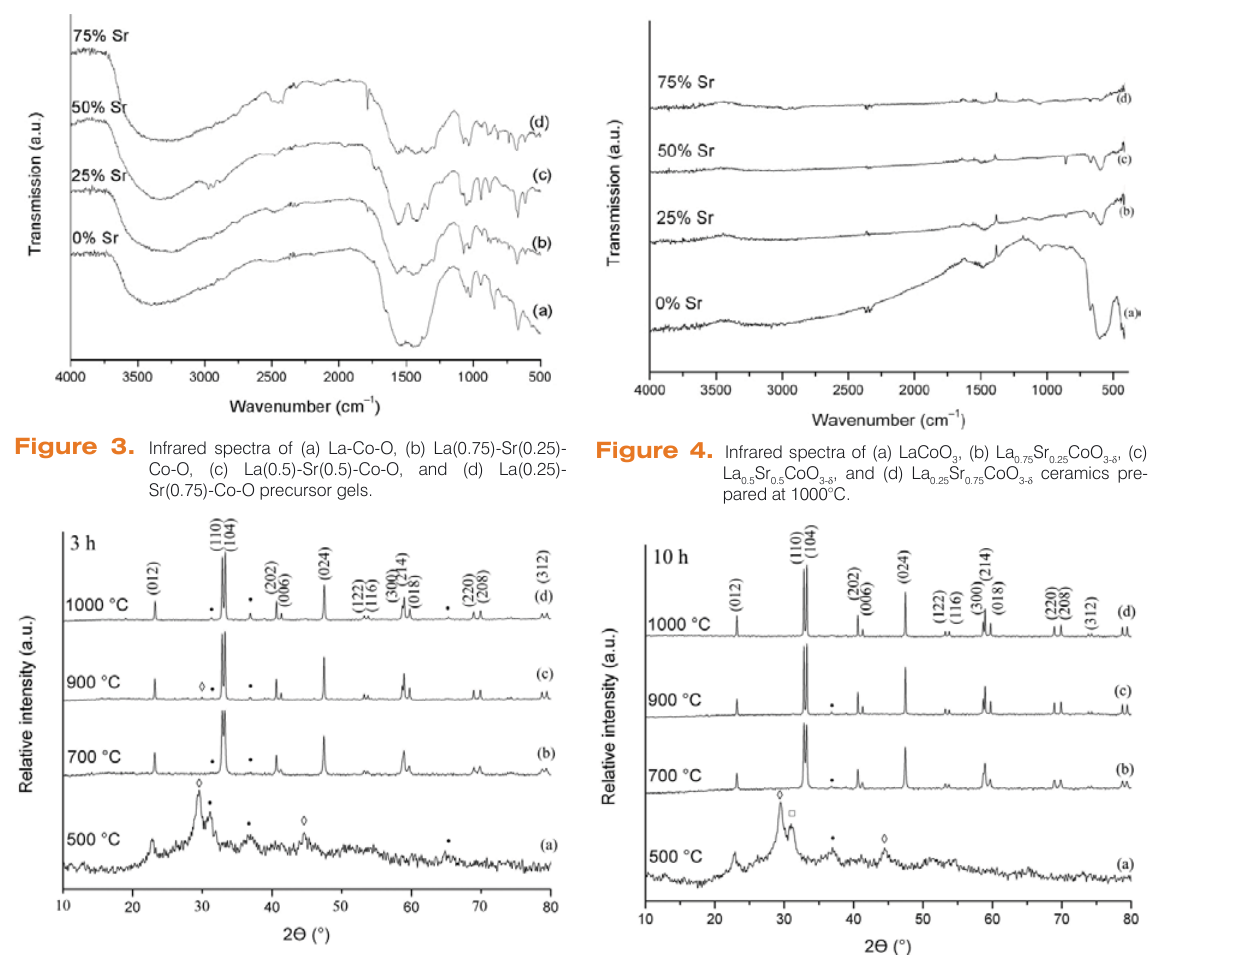
Figure 5. X-ray diffraction patterns of LaCoO using the sol-gel method at different temperatures: (a) 500°C, (b) 700°C, (c) 900°C, (d) 1000°C. Annealing time was 3 h. The Miller indices of LaCoO